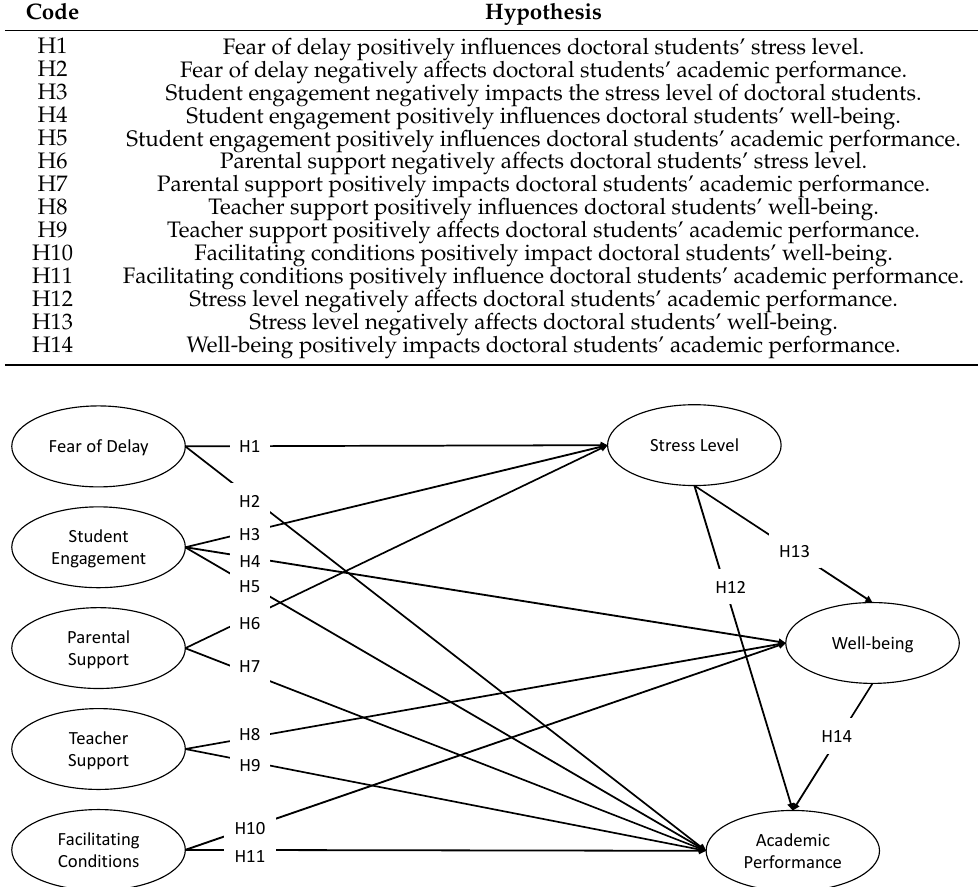
Table 1. Hypotheses in this study.